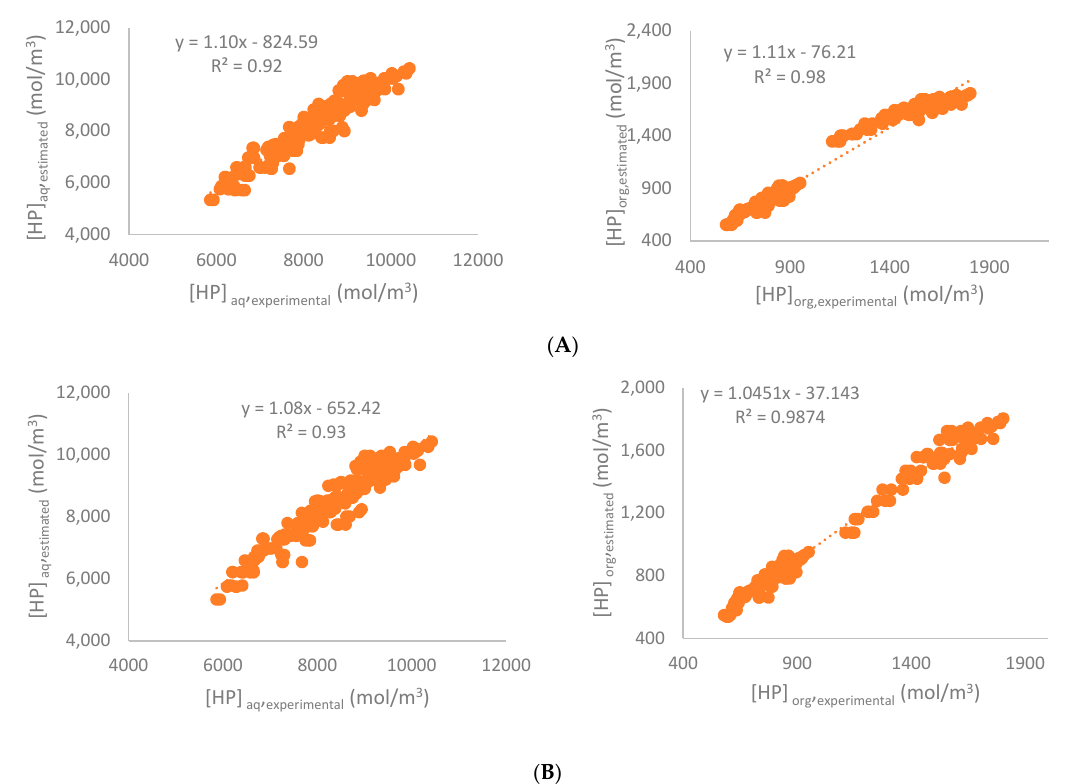
Figure 9. Parity plot for the heterogeneous liquid phase system using Model c ( A ) and Model d ( B ).